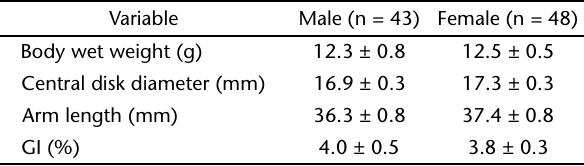
Table I. Morphological measurements (mean ± standard deviation) of E. (O.) guyanensis . No sexual dimorphism was found (all comparisons p > 0.05).